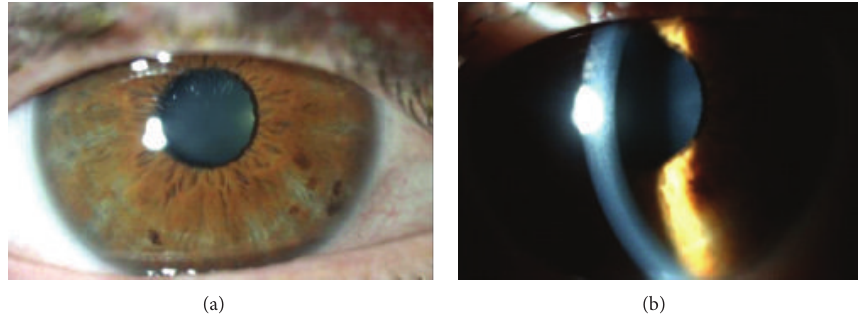
Figure 4: RE: almost complete resolution of the edema.